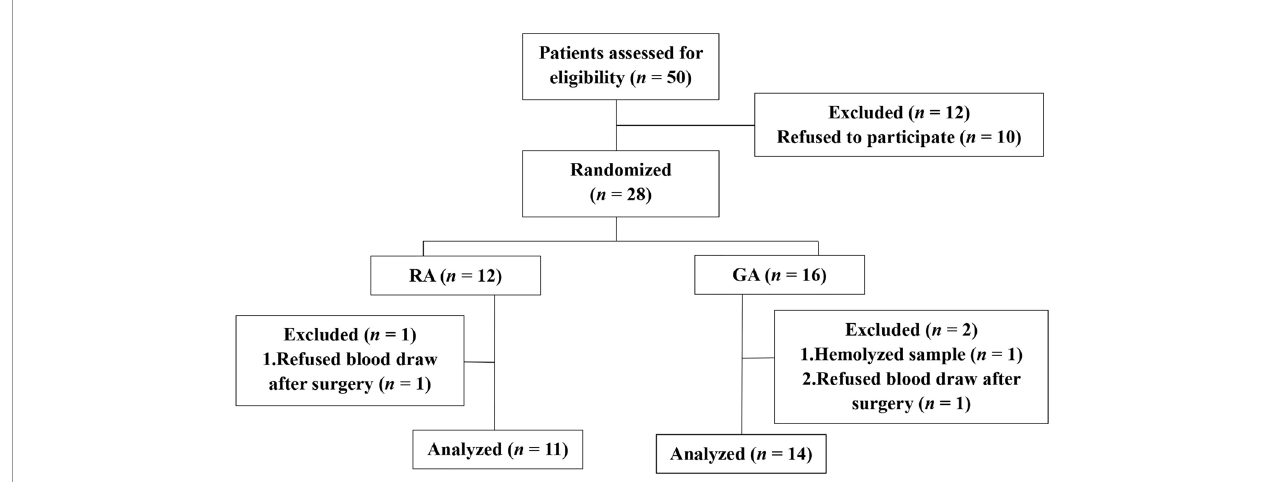
FIGURE 1 | Clinical trial fl ow diagram.28 patients were recruitedand randomized to the LAgroup or GA group. 25 patients were included inthe fi nalanalysis, n = 11, LA group, and n = 14, GA group.